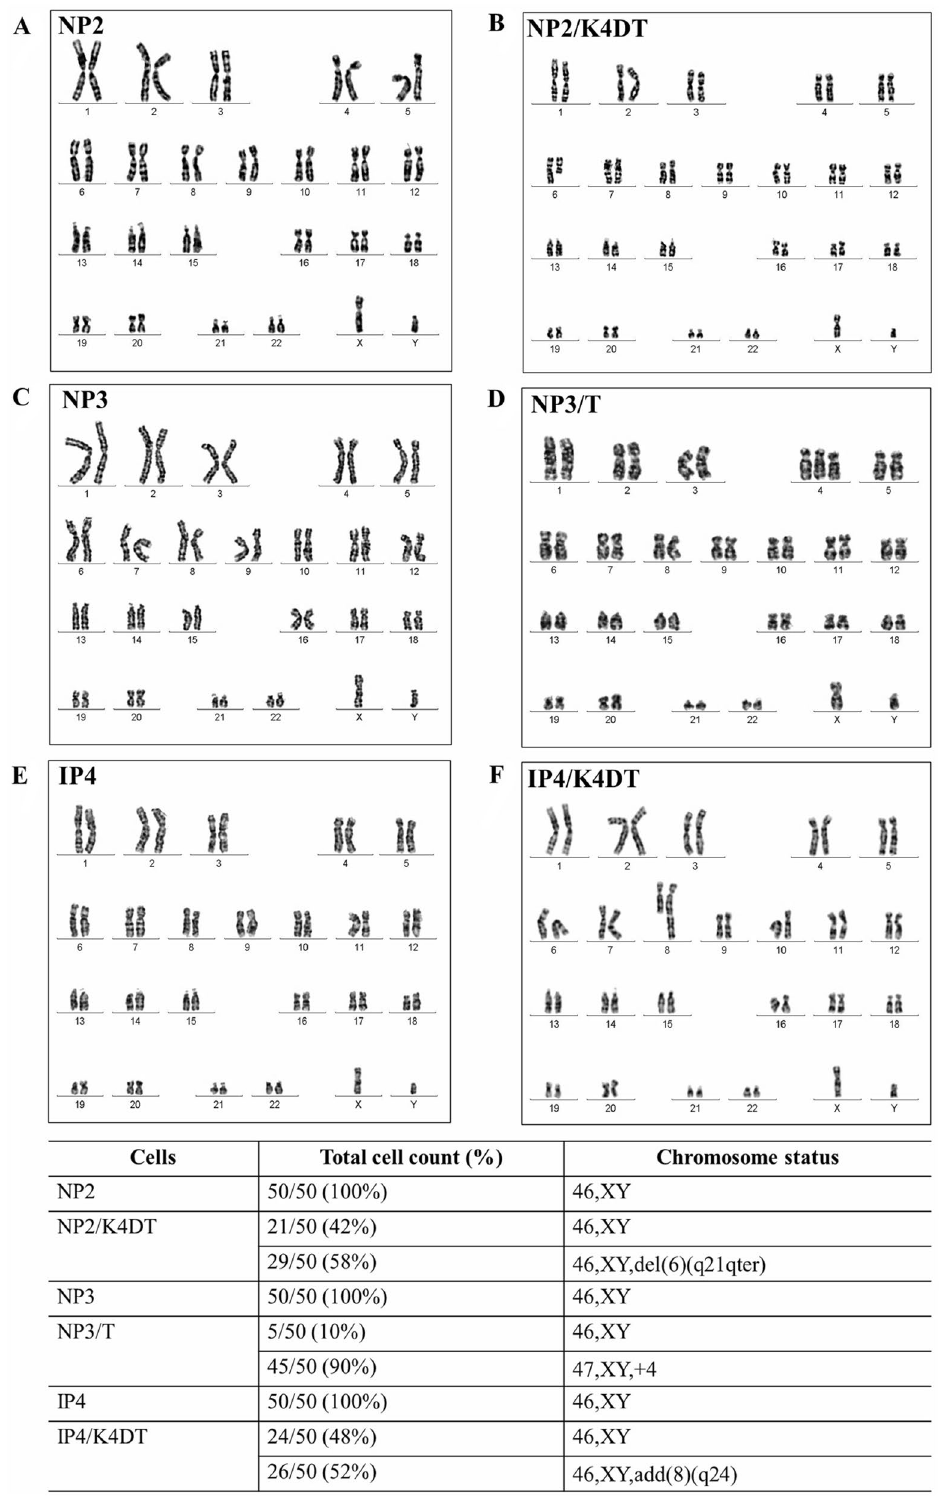
Figure 4. Karyotype variation of primary immortal cells compared to their primary cells. Karyotypes of NP2, NP2/K4DT, NP3, NP3/T, IP4, and IP4/K4DT were analyzed as described in Methods. The normal diploid chromosomes of primary cells ( A , C , E ) and representative images of abnormal karyotypes for NP2/K4DT ( B ), NP3/T ( D ), and IP4/K4DT ( F ) were presented. The results are summarized in the bottom